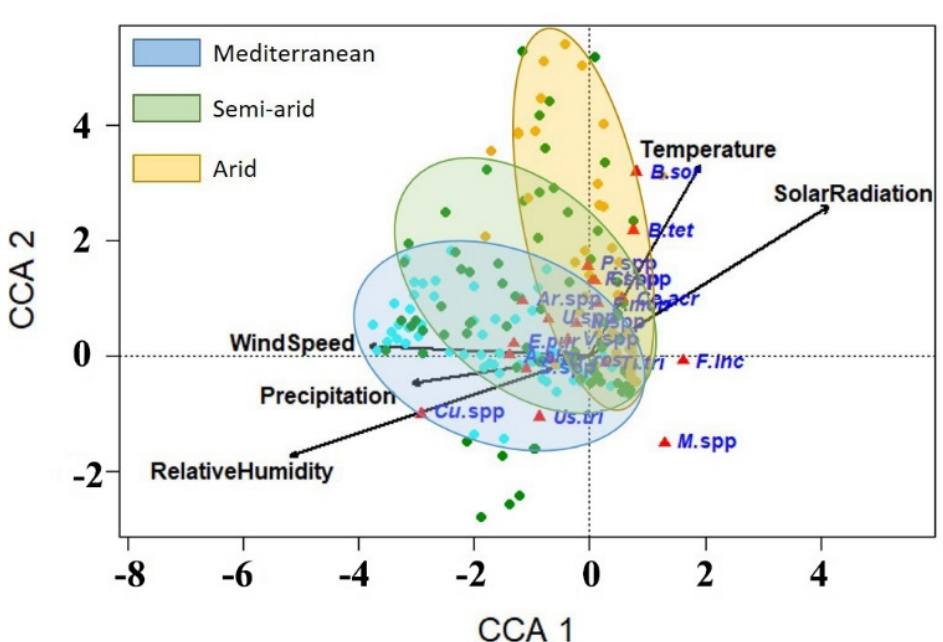
Figure 7. Ordination diagram of canonical correspondence analysis of seed-borne fungi in wheat grain samples from 25 wheat-growing governorates with five explanatory weather variables. Red triangles are fungal pathogens and arrows are weather variables. A. alt = Alternaria alternata, Ar. spp = Arthrobotrys spp ., B. sor = Bipolaris sorokiniana , B. tet = Bipolaris tetramera , Ce. acr = Cephalosporium acremonium, Cl. spp = Cladosporium spp. , Cu. spp = Curvularia spp. , E. pur = Epicoccum purpurascens, F. inc = Fusarium incarnatum, F. spp = Fusarium spp. , F. ver = Fusarium verticillioides, M . spp = Mucor spp ., N. spp = Nigrospora spp ., P. spp = Penicillium spp ., S. spp = Stemphylium spp. , Ti. tri = Tilletia tritici, Tr. ros = Trichothecium roseum, U. spp = Ulocladium spp., Us. tri = Ustilago tritici , and V. spp = Verticillium spp. Each small solid circle represents a sampling site where a pathogen was detected and grouped into climatic zones of Egypt: Mediterranean in blue, semi-arid in green, and arid in yellow.